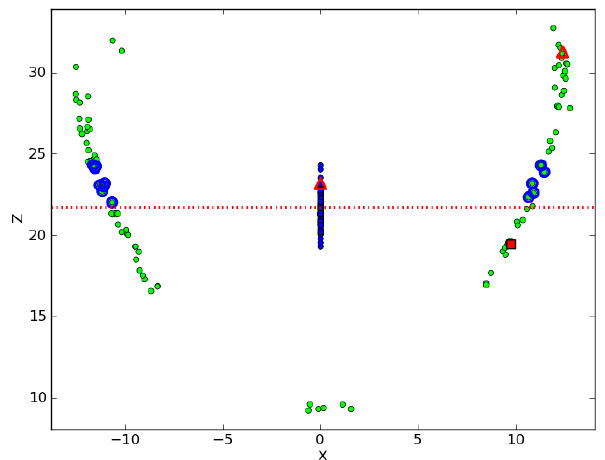
Figure 5. Illustration of the MRHF analysis step for the first unob- served variable: green dots represent the prior ensemble; blue dots vertically aligned at X = 0 represent the posterior z ensemble. The red dotted line is the observation of z , the red square is the true state (not used for the analysis). The red empty triangles show the particle being processed and its corresponding z analysis value. Blue circles show the selected particles to form the posterior density p a text for details.